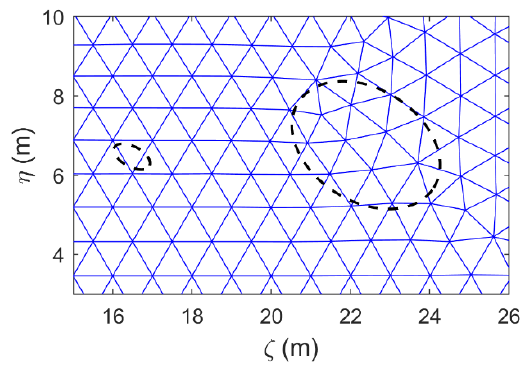
Figure 2. Rectangular domain with an element size of 1 m. Black ellipses indicate the initial/final condition.